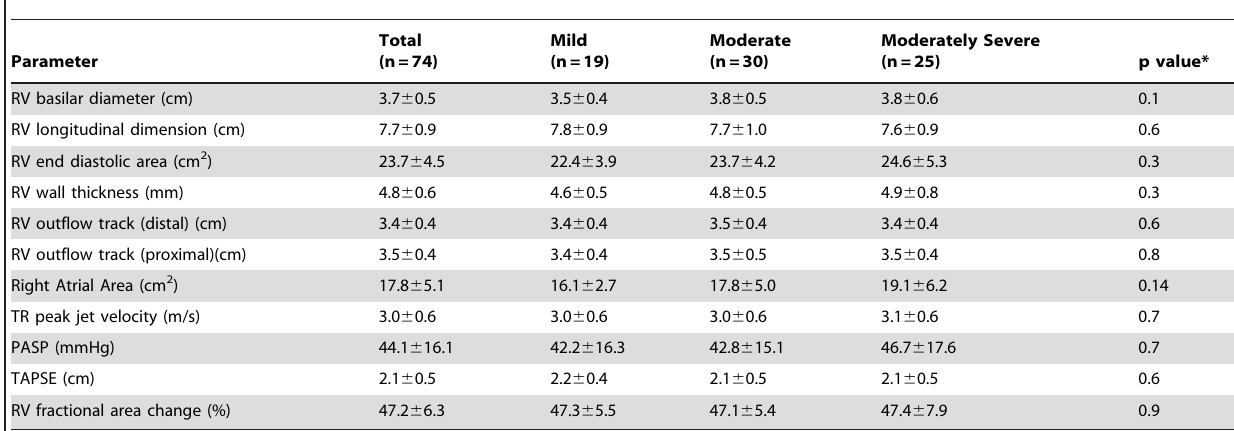
Table 2. Right Heart Parameters by COPD